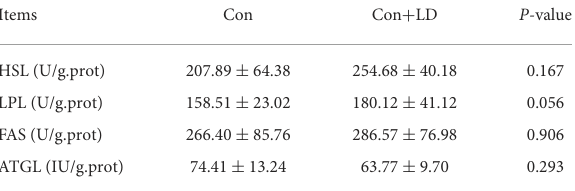
Con, basal diet; Con + LD, basal diet + 0.1 % L. delbrueckii; HSL, Hormone sensitive lipase; LPL, Lipoprotein lipase; FAS, Fatty acid synthetase; ATGL, Adipose triglyceridelipase.